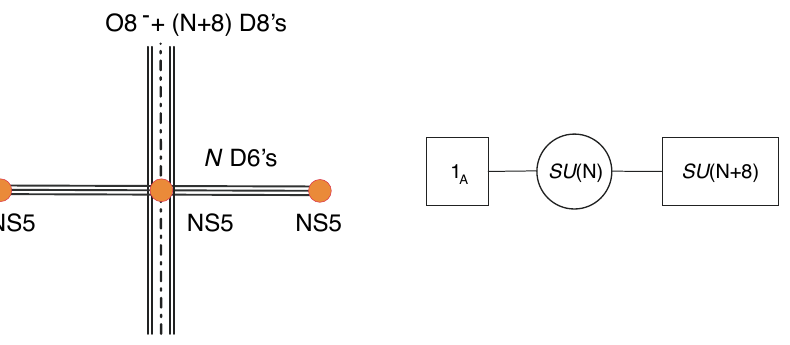
Figure 7 . Left: type IIA brane set up for 6d SU( N ) gauge theory with N Right: corresponding quiver